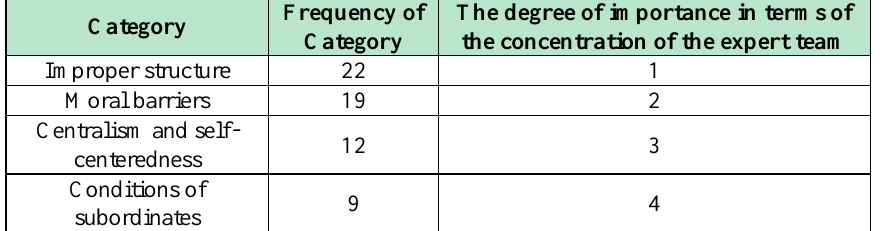
Table 3: Grading the importance of barriers affecting the